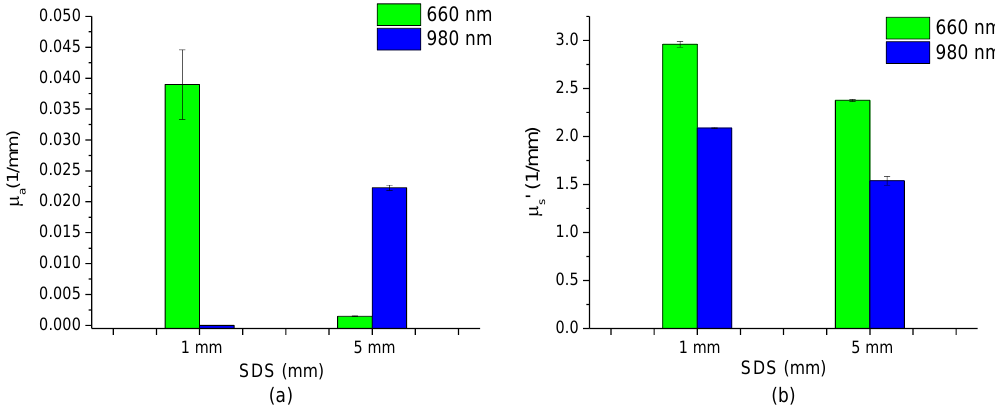
Figure 3. ( a ) Absorption and ( b ) reduced scattering coefficients of an apple recovered at 660 nm wavelength (green bar) and 980 nm (blue bar) at source–detector separation (SDS) of 1 mm and 5